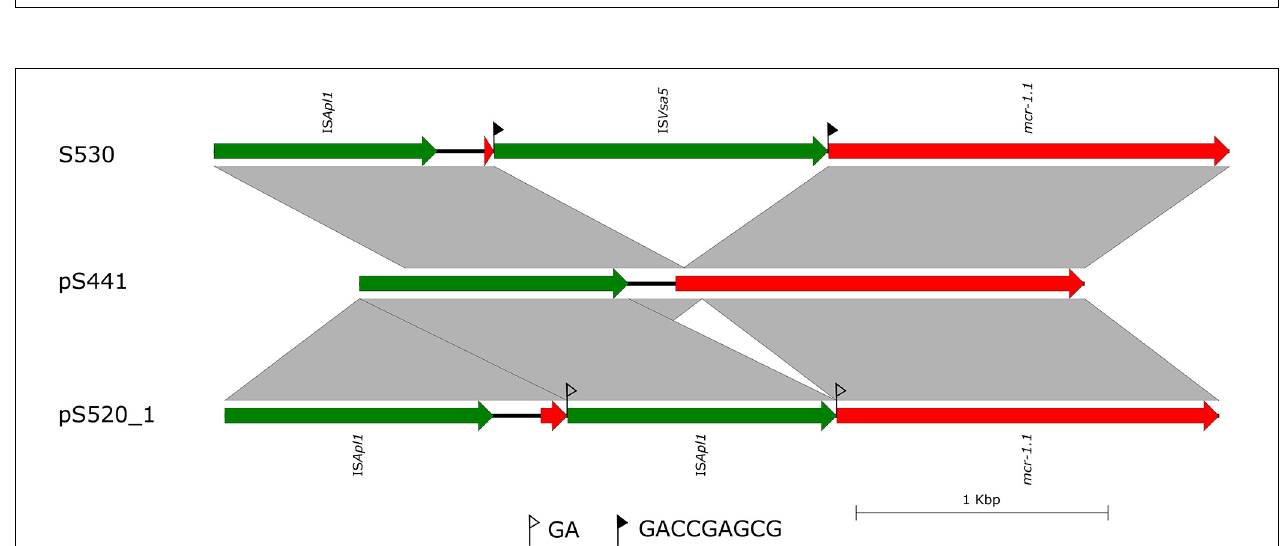
FIGURE 3 | Scaled, linear diagrams comparing the sequences of S530, plasmid pS441, and pS520_1. Insertion elements are shown as green arrows. Genes, including antibiotic resistance genes, are shown as labeled red arrows. Flags indicate the 8 bp target site duplications (TSDs).